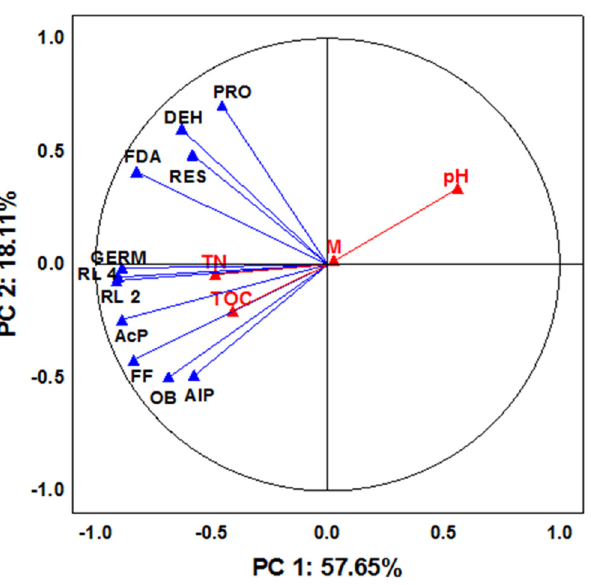
Figure 6. Principal component analysis (PCA) for the results of analyzed parameters in the soil. OB—oligotrophic bacteria, FF—filamentous fungi, RES—respiration of soil, DEH—dehydrogenases, PRO—protease, FDA—fluorescein diacetate hydrolysis activity, AcP—acid phosphatase, AlP—alkaline phos- phatase, GERM—germination of L. sativum , RL2—root length of L. sativum after two days,